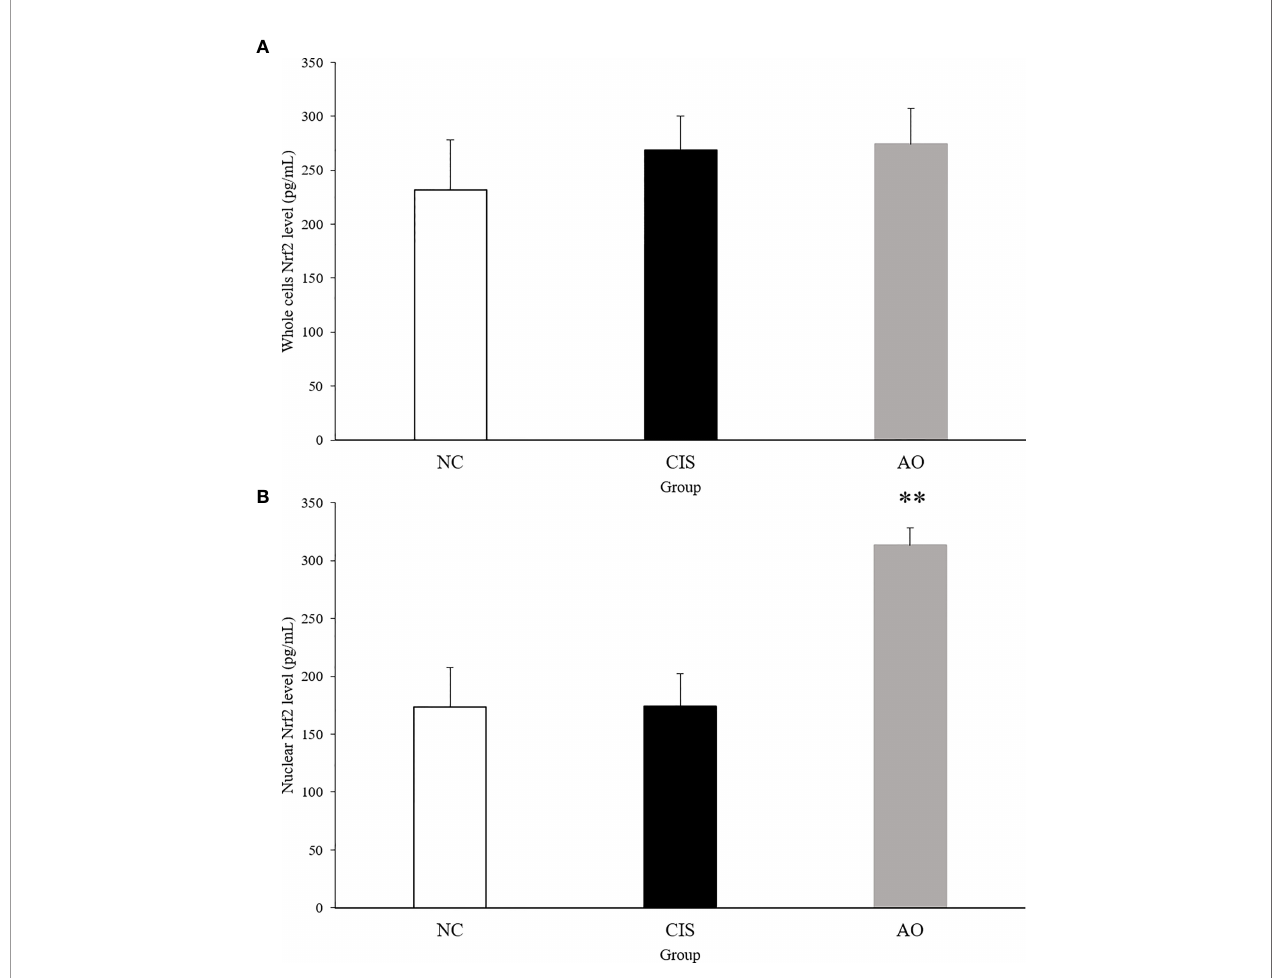
FIGURE 7 | Nrf2 protein level in kidney tissue. (A) Whole cell Nrf2 protein level in kidney tissue; (B) nuclear Nrf2 protein level in kidney tissue. The signi fi cance marker on AO indicates AO vs. CIS (** p< 0.01). n=10 for the AO and NC groups, n=7 for the CIS group (three mice in the CIS group died before